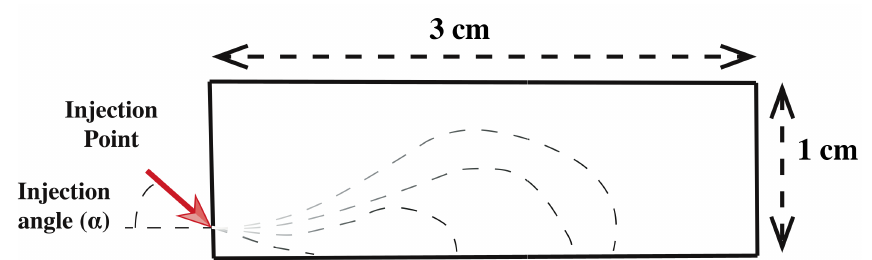
Figure 2. Schematic of the two-dimensional computational domain. Dash lines replicates the development of